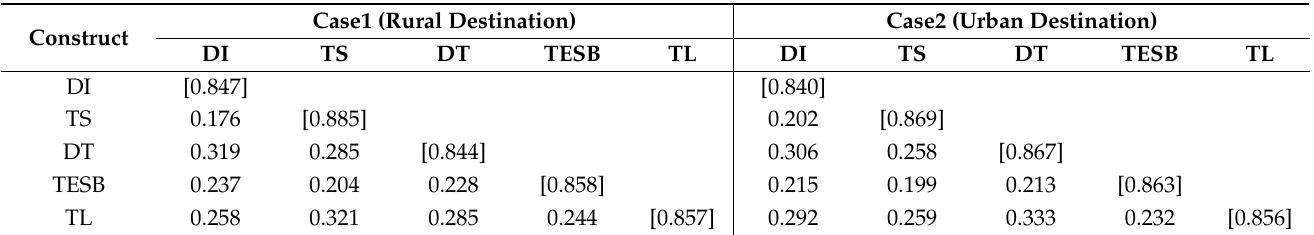
Table 3. Results of discriminant validity.